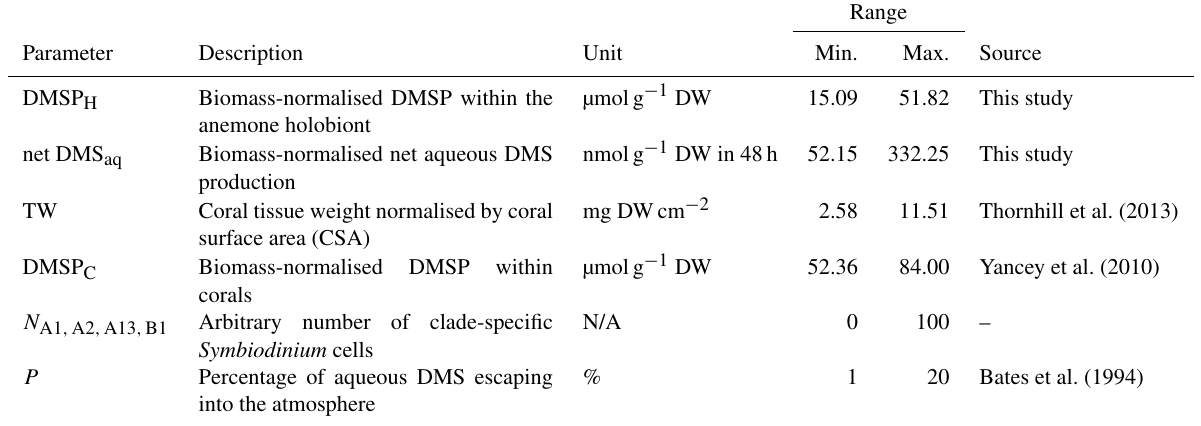
Table 1. Parameters used for the simulation. DMS, dimethylsulfide; DMSP, dimethylsulfoniopropionate; DW, dry weight; N/A, not applica- ble. Note that the simulation was unaffected when setting N (the arbitrary number of clade-specific Symbiodinium cells) to maximum values of 10 3 or 10 6